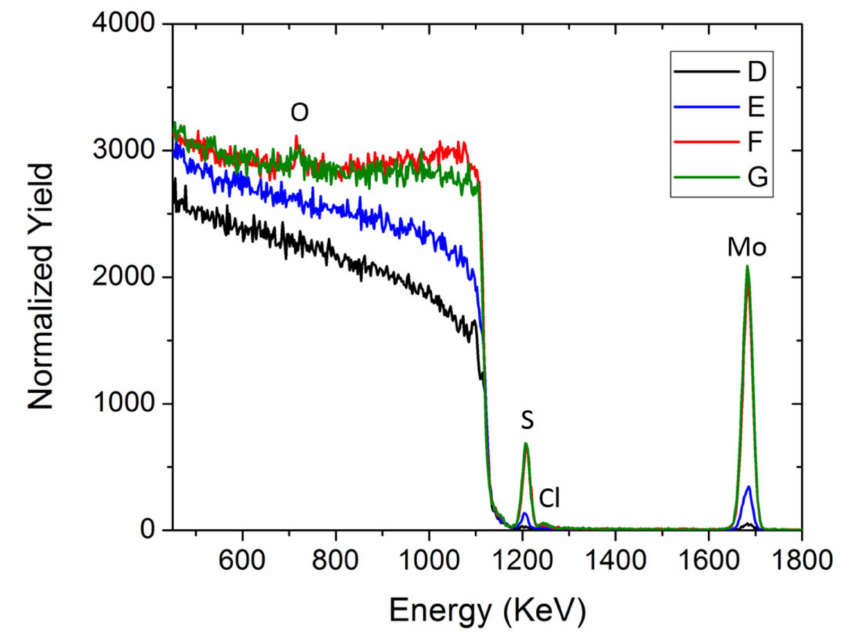
Figure 3. RBS spectra of the D, E, F and G